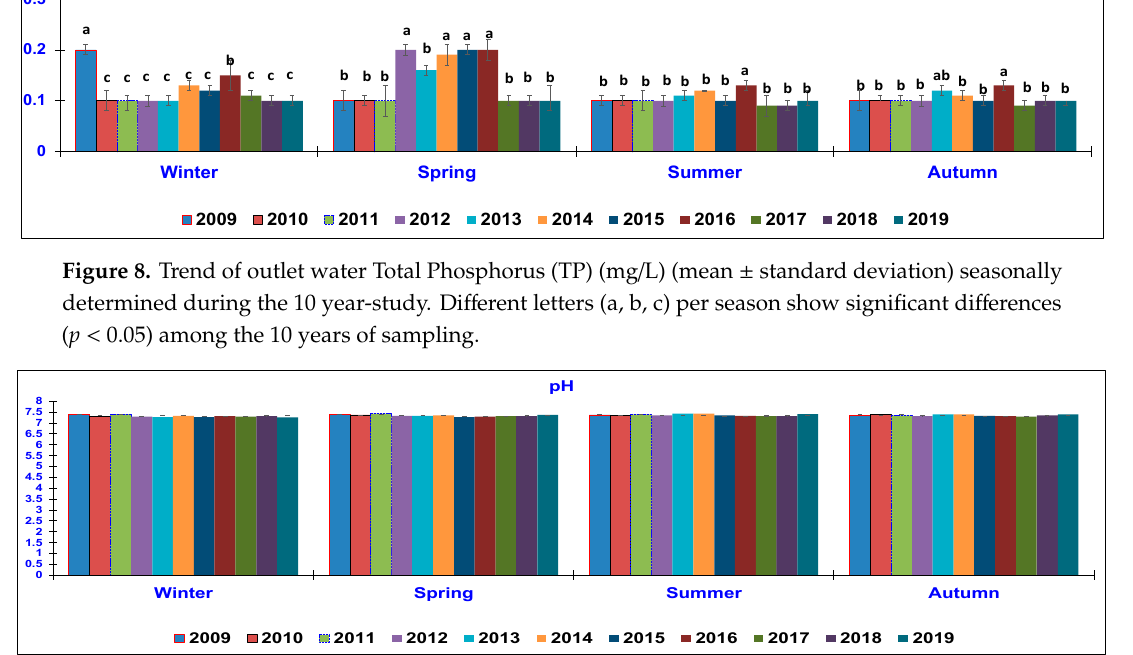
Figure 9. Trend of outlet water pH (mean ± standard deviation) seasonally determined during the 10 year-study.